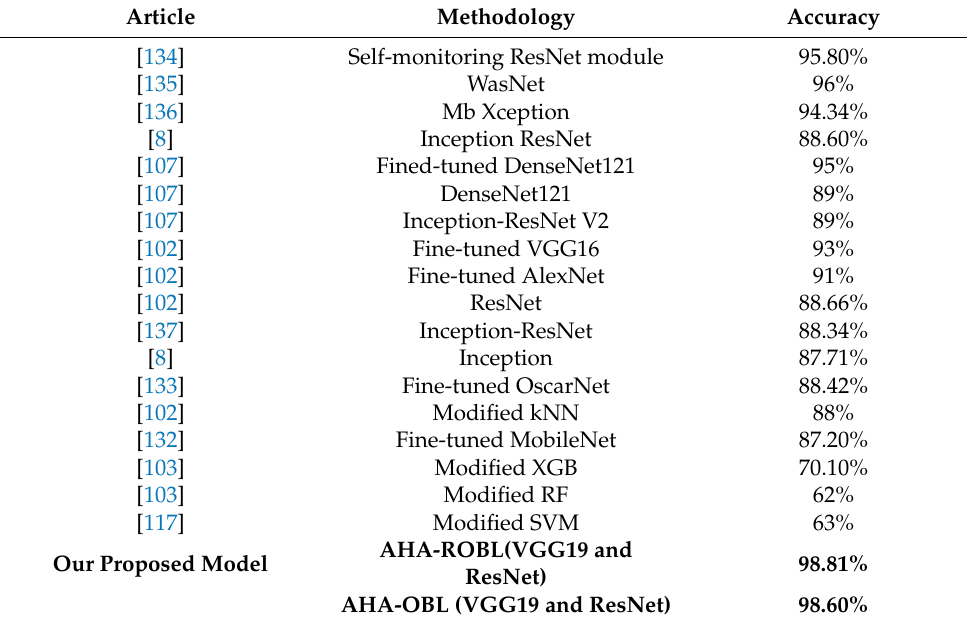
Table 12. A comparative study of the AHA-ROBL based on pre-trained CNNs with existing algo- rithms for TrashNet